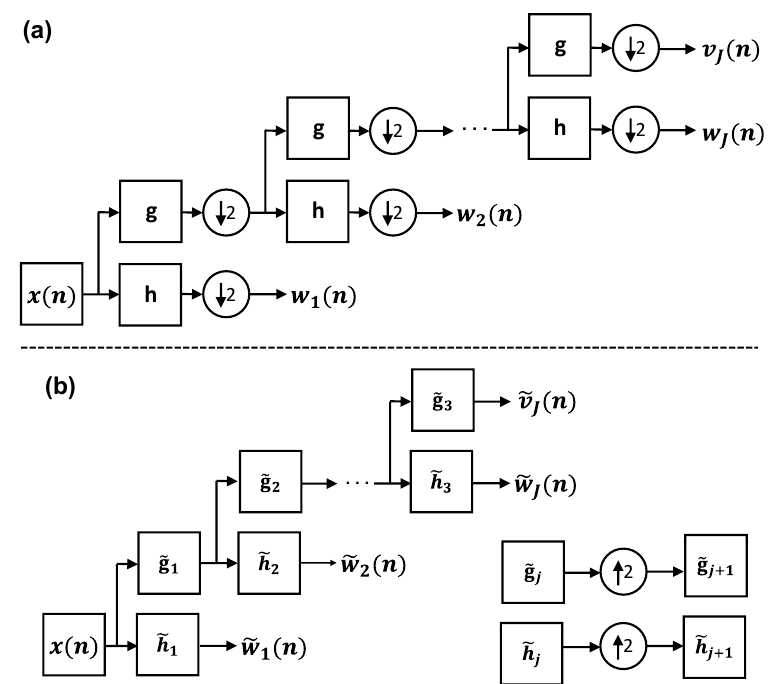
Figure 1. ( a ) The block diagram of the DWT pyramid algorithm. The input signal x ( n ) is filtered recursively by a set of high-pass wavelet and low-pass scaling filters. The output of each filter is downsampled by a factor of two. ( b ) The block diagram of the MODWT pyramid algorithm. In MODWT, the sampling rate is the same at all levels of decomposition. However, the ( j + 1 ) th-level filters are upsampled by a factor of two with respect to the j th-level